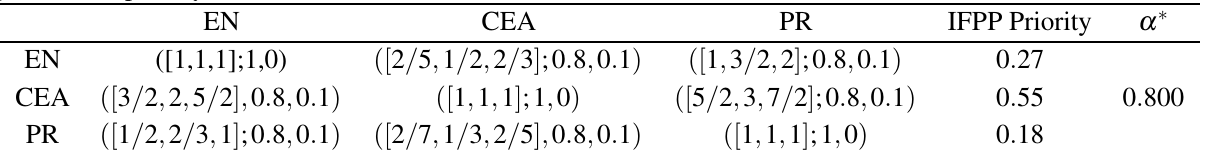
Table 5: Generalized intuitionistic fuzzy pair-wise comparison matrix of three main attributes with respect to goal and its priority